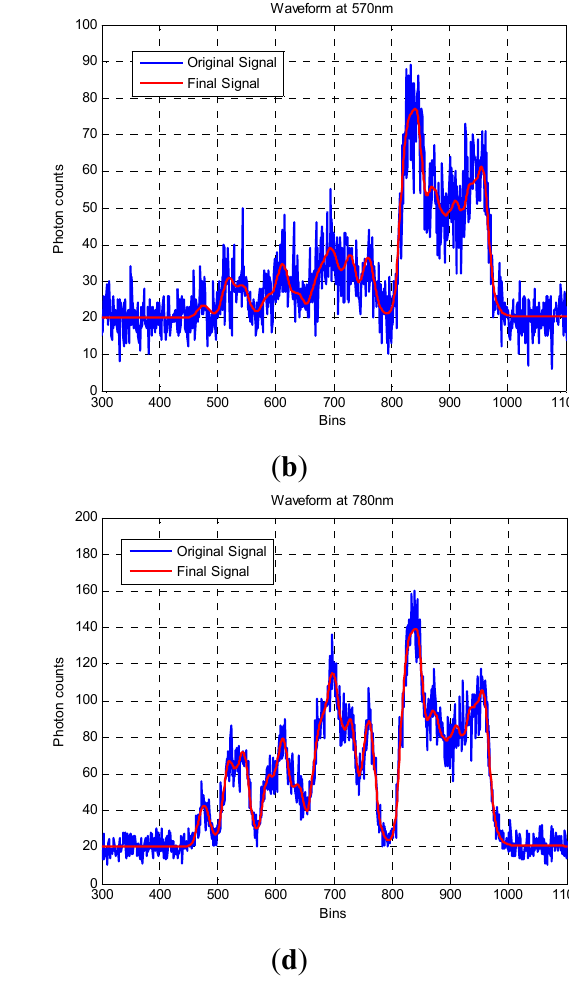
Figure 9. Results from repeated RJMCMC analysis on noisy multispectral data. ( a – d ) show fitted results from one trial at wavelengths 531 nm, 570 nm, 690 nm and 780 nm respectively. ( e ) shows the recovered area values as a function of bin number through the canopy for all 15 trials. ( f ) shows as scattered points the recovered C values, as a solid ab black line a regression fit to the scattered points, and as a solid red line the ground truth, i.e. , the modeled C ab